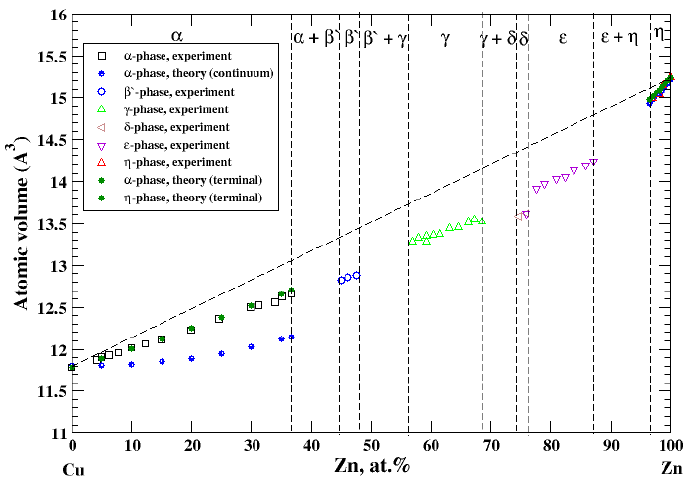
Figure 11. Atomic volume vs. concentration for Cu-Zn alloy system. The experimental data are from Ref. [16] (p. 620 and p.